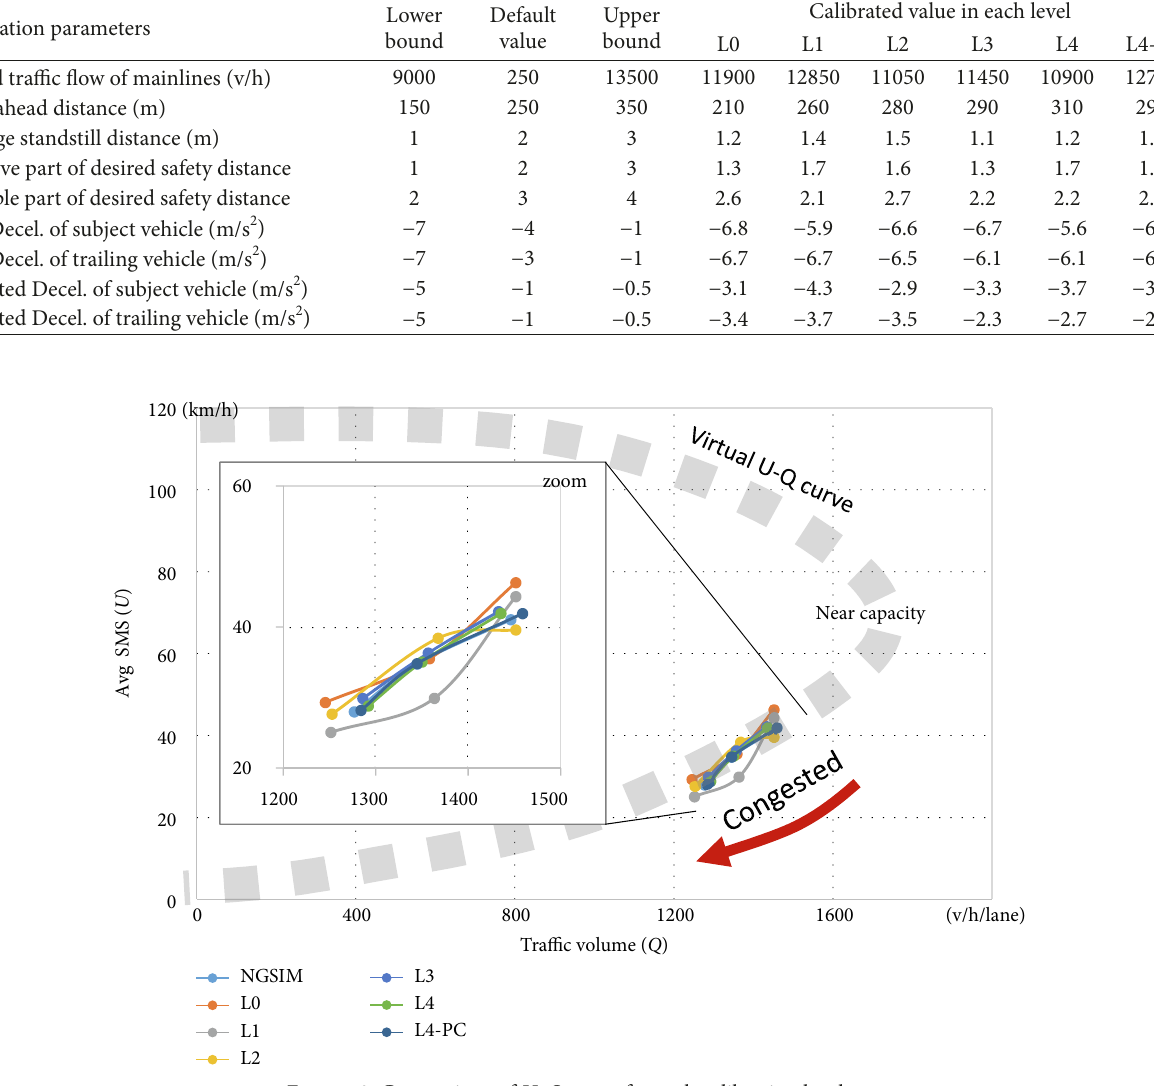
Figure 3: Comparison of U–Q curve for each calibration